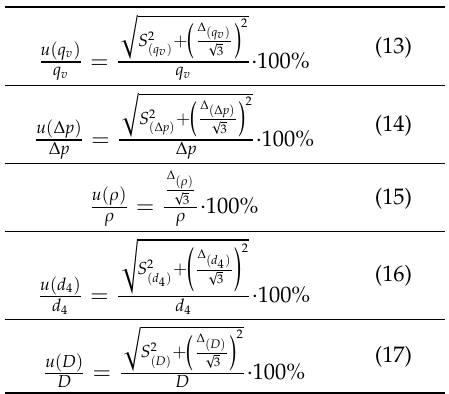
Table 3. Relative standard components of the uncertainty of Equation